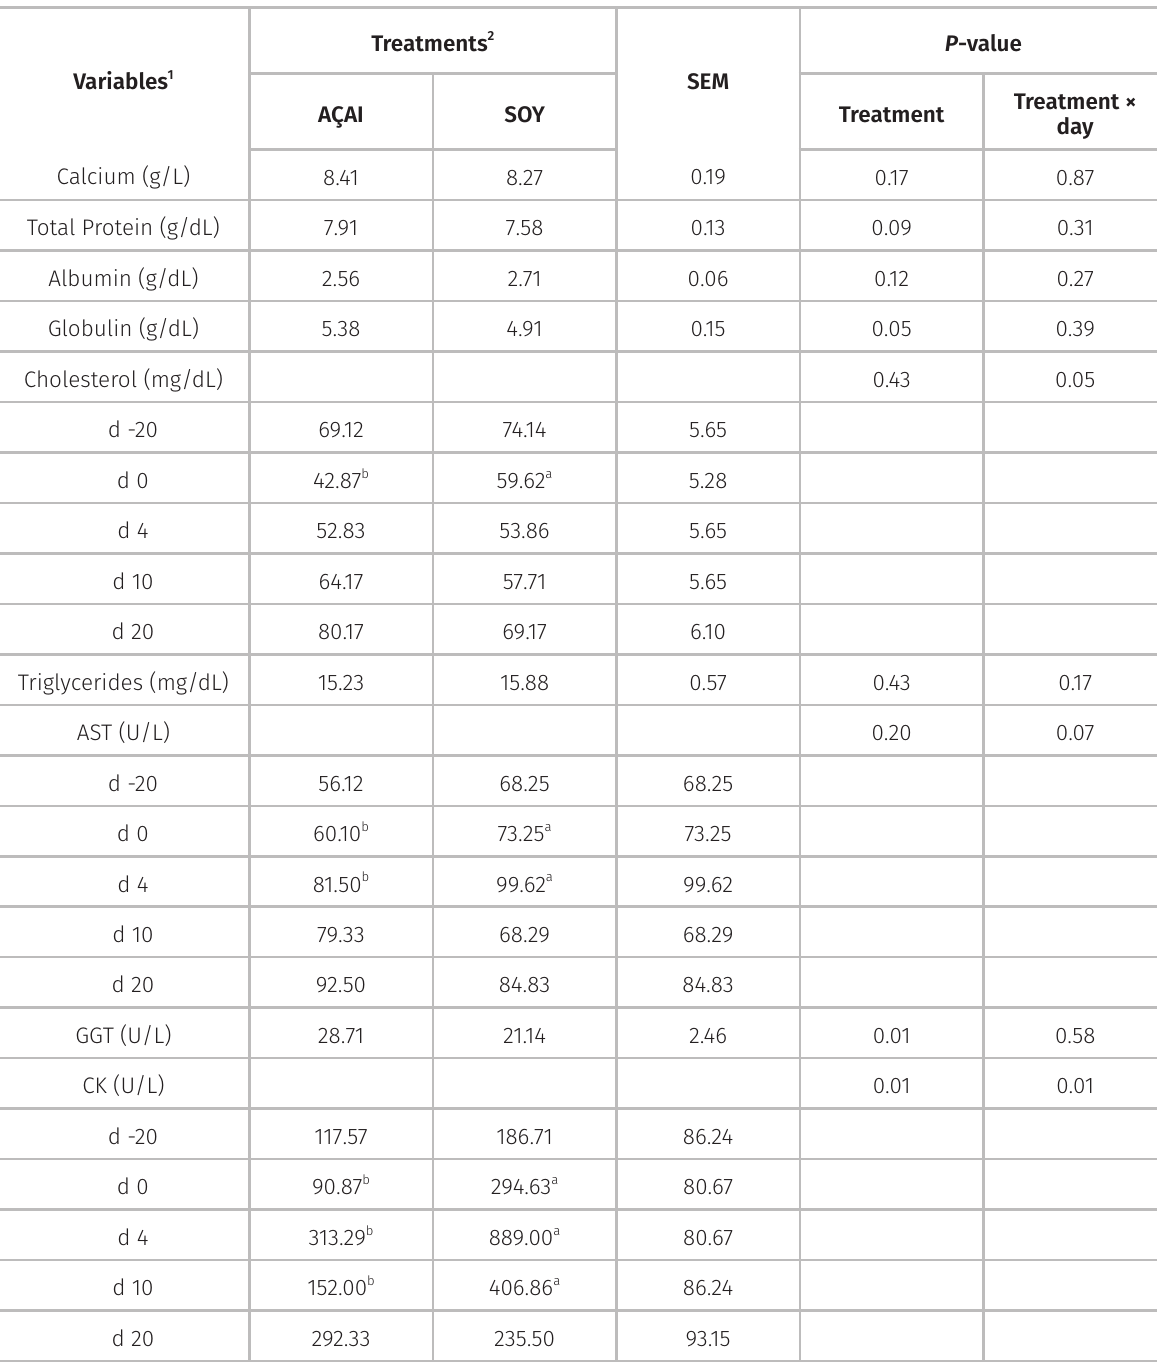
Table III. Serum biochemistry variables of cows fed with açai oil or soybean oil during the prepartum period: analyzes made in the pre- and postpartum (20 days prepartum, day of partum, and 4, 10, 20